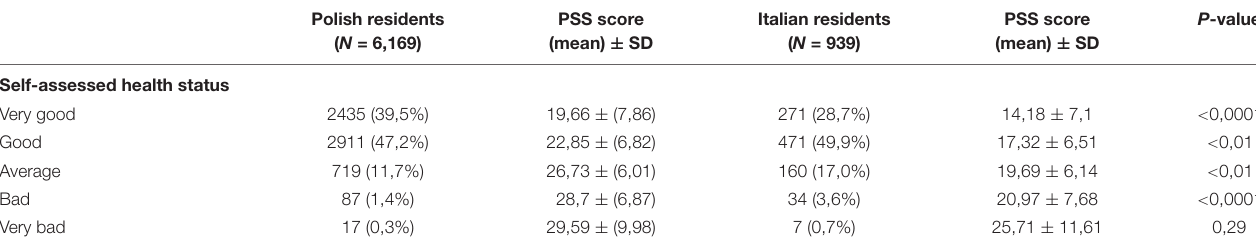
TABLE 2 | Perceived Stress Scale (PSS-10) scores in Polish and Italian respondents.